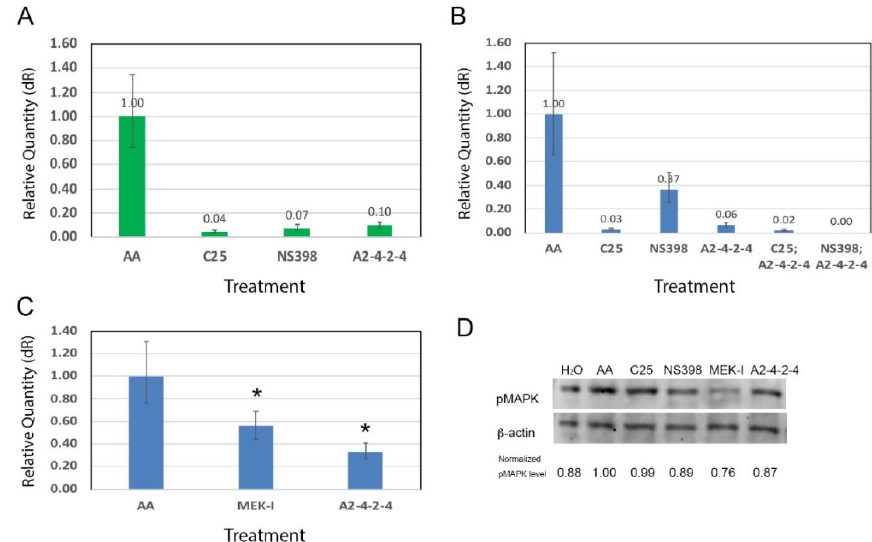
Figure 5. Possible molecular mechanisms of A2-4-2-4. ( A ) The COX-2 gene expression, measured by qRT-PCR, was high in embryos treated with AA alone but significantly lower in those treated with AA plus C25, NS398, or A2-4-2-4. ( B ) A2-4-2-4 showed a synergistic effect with NS398 in suppressing inflammation. While the COX-2 expression level in embryos treated with AA and a sub-dosage of NS398 was 0.37 folds of that in embryos treated with AA alone, the COX-2 level was near zero in the embryos treated with NS398; A2-4-2-4. ( C ) The tnnt-2 expression, an indicator of cardiac hypertrophy, was high in embryos treated with AA alone but significantly lower in embryos treated with AA plus MEK-I or AA plus A2-4-2-4. (* indicates statistical significance between the compound and AA control, t -test, p < 0.05.) ( D ) Western blotting with anti-phosphorylated MAPK (pMAPK) showed that A2-4-2-4 moderately suppressed the MAPK signaling pathway. The normalized pMAPK level was done by dividing the band intensity in pixels using photoshop of pMAPK by that of β -actin for each